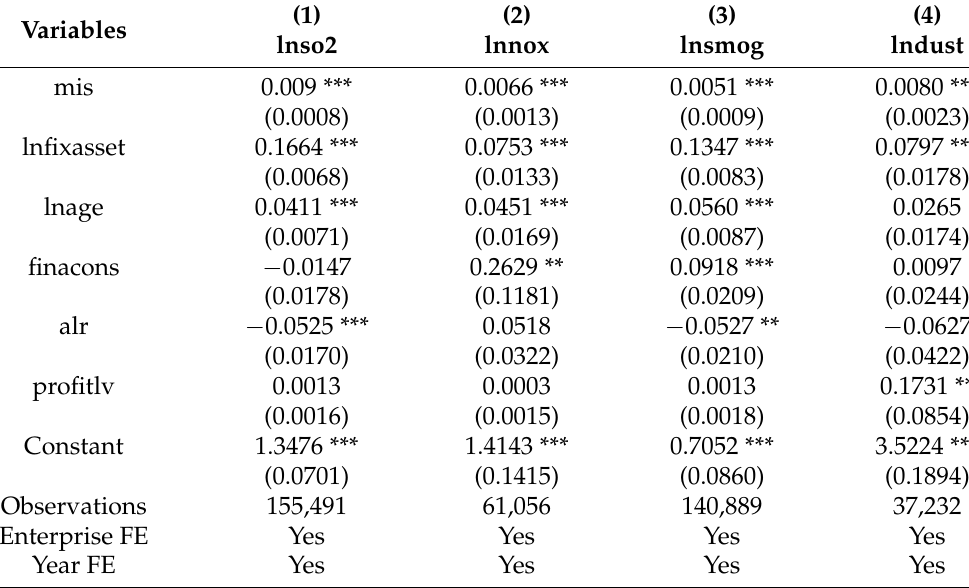
Table 3. Effects of resource misallocation on different pollutant